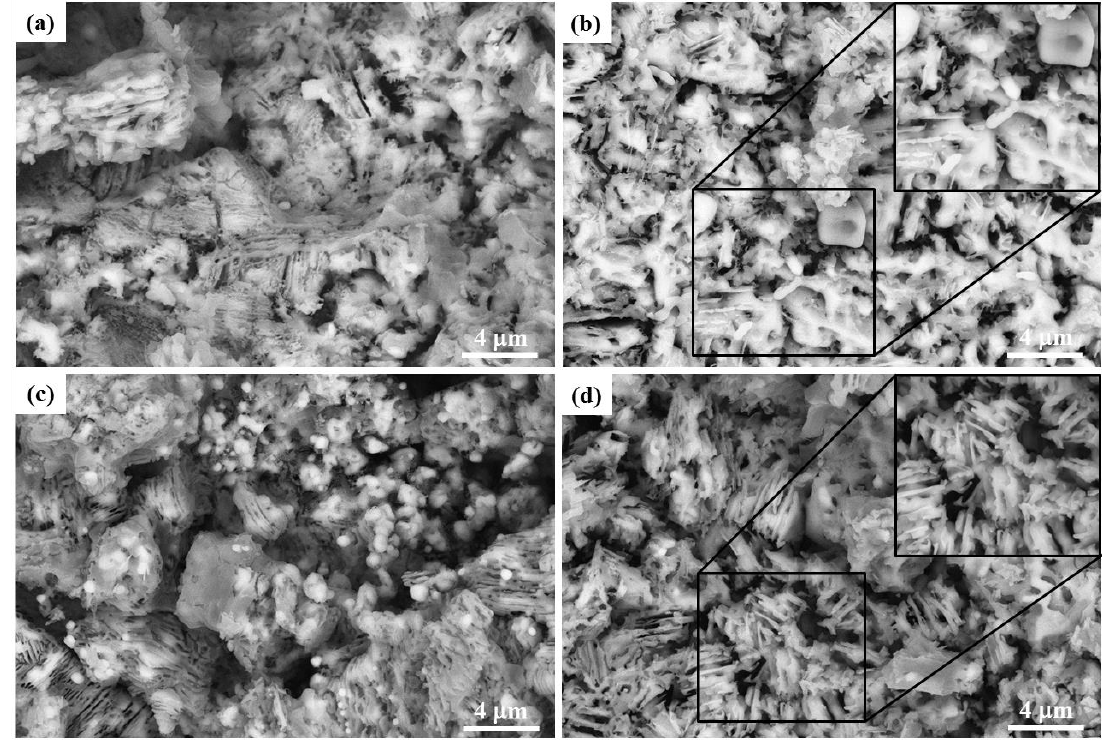
Figure 16. SEM images of reduced CVTP with Co 2 O 3 additions: ( a ) 0 wt %, ( b ) 2 wt %, ( c ) 4 wt %, and ( d ) 6 wt %.